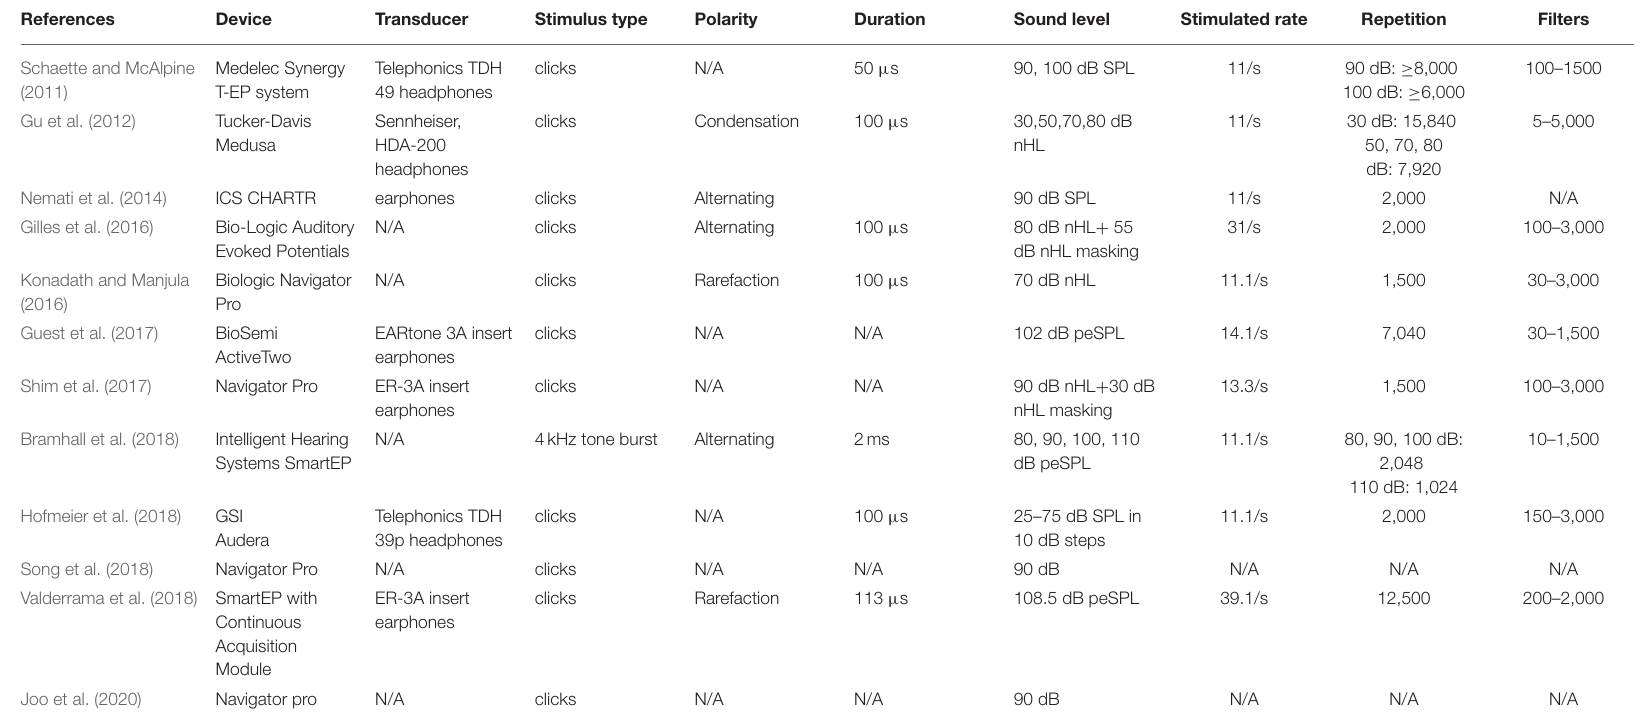
TABLE 2 | ABR methodology of the included